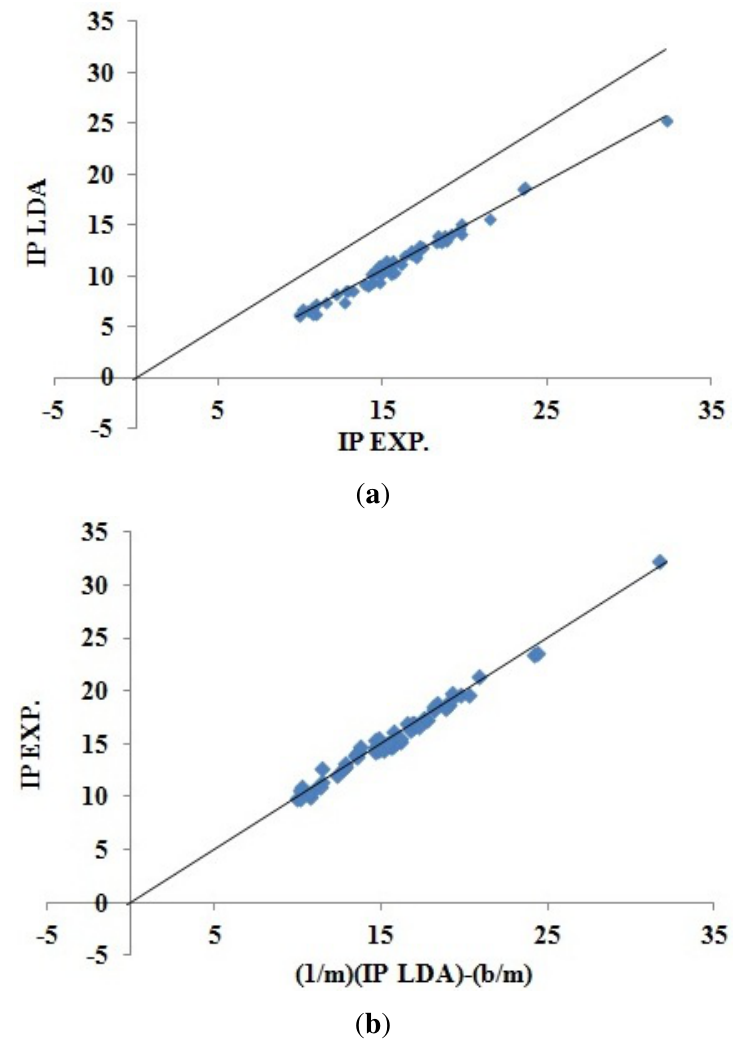
( a ) Correlation plot for LDA “Koopmans’ theorem IPs” versus experimental IPs [40]; ( b ) inversion plot for the same data constructed using Equation (40) to show the “predictive ability” of the LDA least squares fit. The units for both axes in these plots are